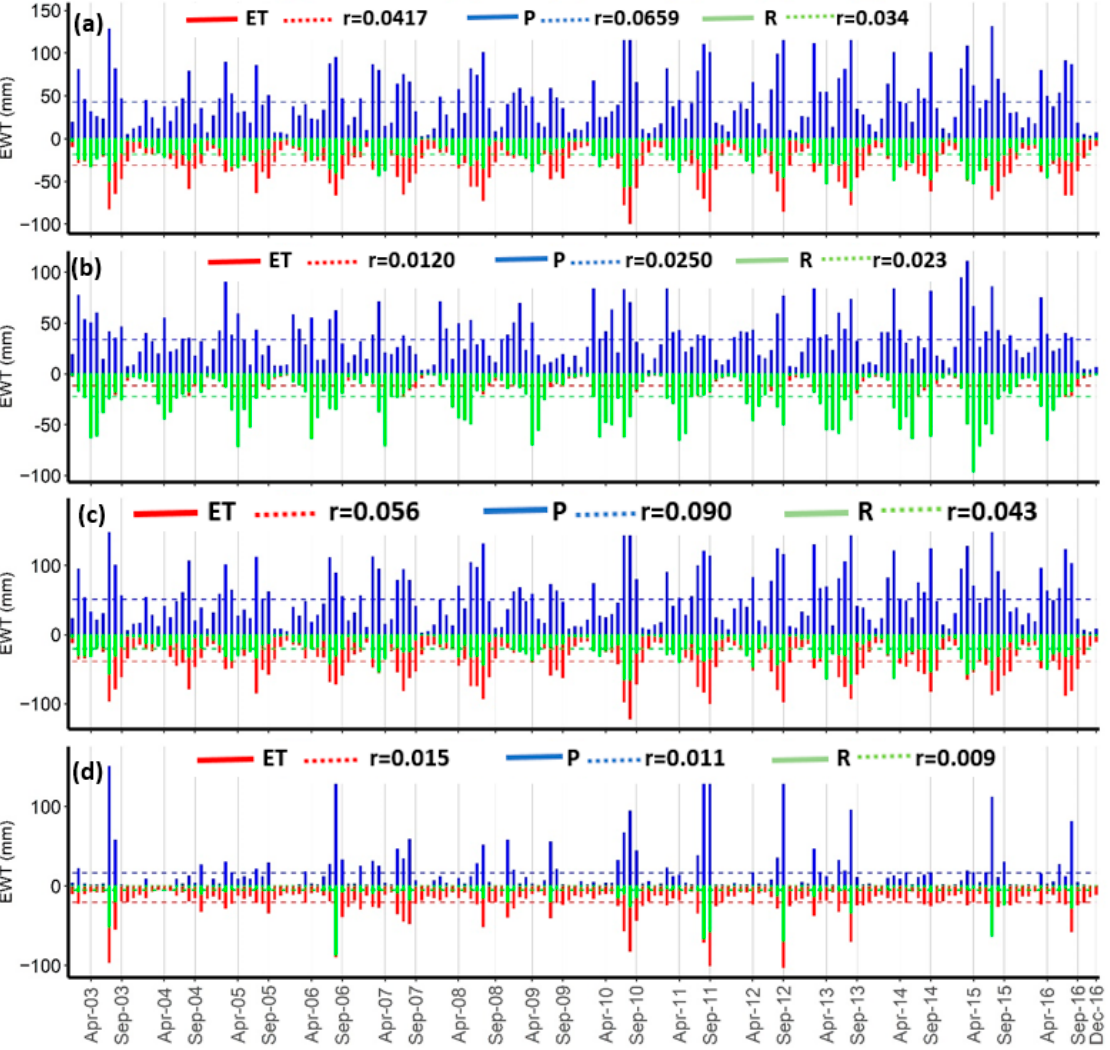
Figure 6. Time series analysis of P, ET, and R in ( a ) the entire Indus Basin, ( b ) Upper Indus Basin (UIB), ( c ) Middle Indus Basin (MIB), and ( d ) Lower Indus Basin (LIB). Here, ‘r’ (mm/month) denotes the rate of change from 2003 to 2016.